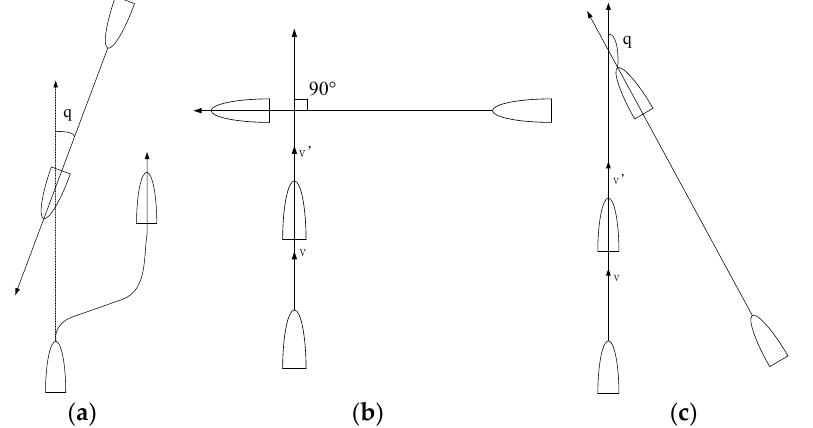
Figure 3. The illustration of a crossing situation ( a ) small angle crossing, ( b ) right angle crossing, and ( c ) large angle crossing.